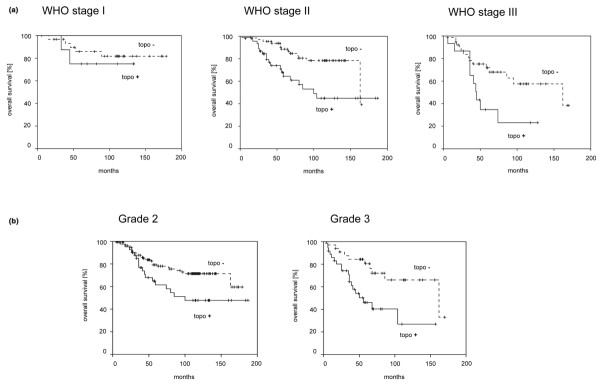
Prognostic impact of topoisomerase IIα protein expression with regard to stage and grading. Patients with tumors positive for topoisomerase IIα in more than 25% of tumor cells (solid lines) were compared with those having tumors expressing topoisomerase IIα in less than 25% of cells (dashed lines) with regard to the stage (a) and the grading (b) of the tumor. The difference was significant in tumors of stage 2 and 3 (P < 0.05) and in grade 2 and 3 tumors (P < 0.05).